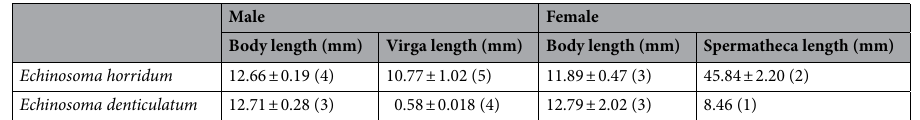
Table 1. Measurements of the body length and genitalia of Echinosoma horridum and E. denticulatum , mean ± sd. Forceps lengths were included in the body size measurements. The numbers in the parentheses represent the number of individuals used for measuring the